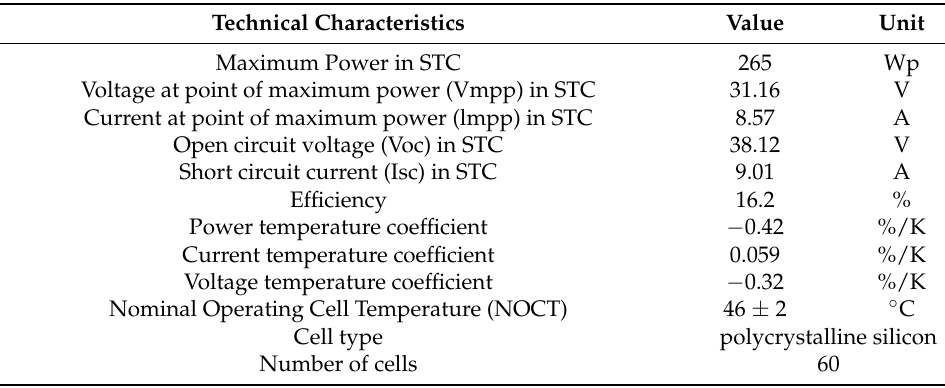
Table 1. Technical characteristics of the photovoltaic modules.